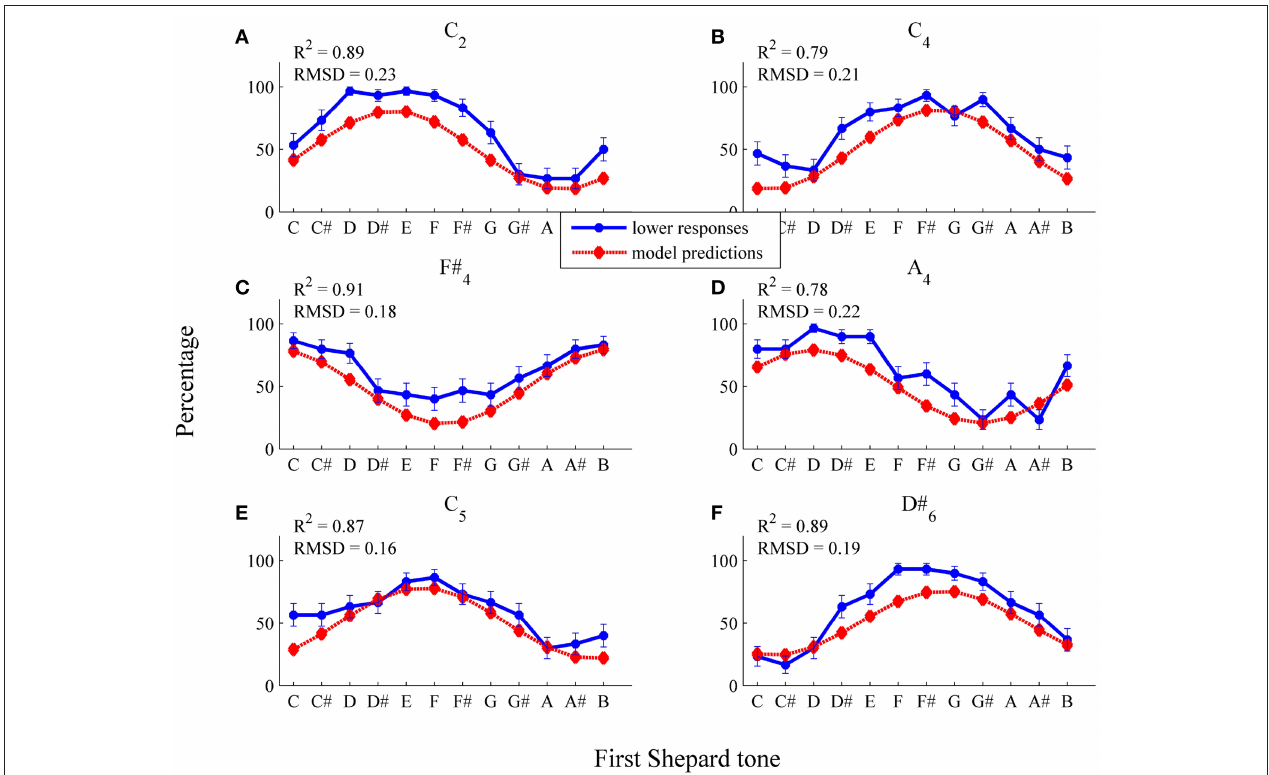
FIGURE 11 | Fitted pronounced pitch class effects (participant AM): average percentages of lower responses (blue dots and unbroken line) in comparison to model predictions for the six envelopes (A) C 2 , (B) C 4 , (C) F # 4 , (D) A 4 , (E) C 5 , (F) D # 6 (red diamonds and dotted line; estimated model parameters: q σ 2 0.50, ˆ l 12.02, ˆ = = − ˆ =